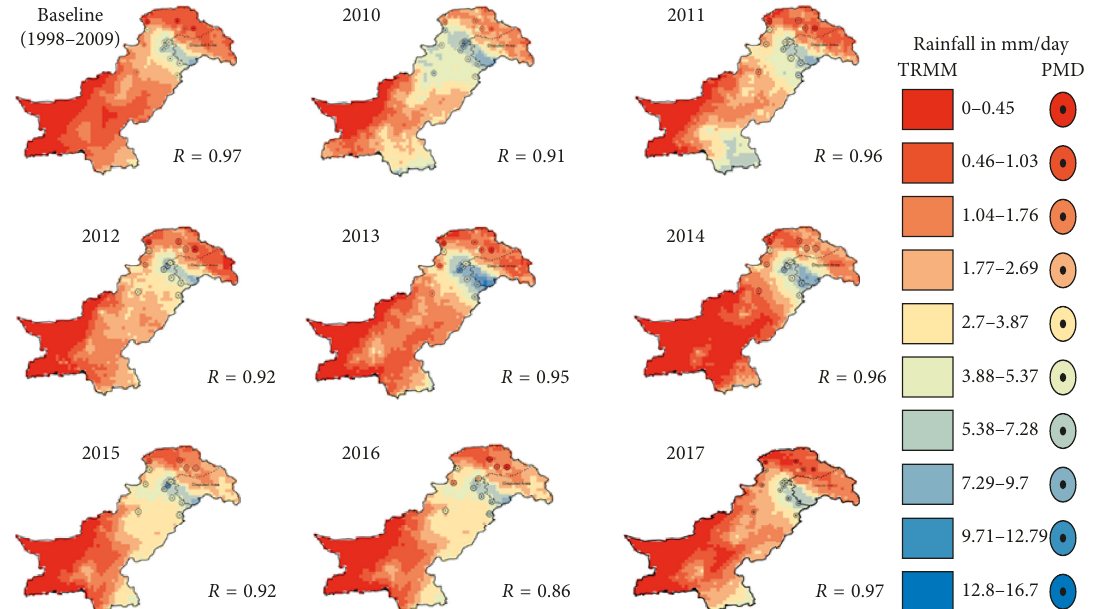
Figure 3: Maps showing rainfall over Pakistan. Correlation between PMD and TRMM_3B43 for seasonal averaged values over selected northern monsoon belt of Pakistan for monsoon season is also listed for respective year. Both the datasets are strongly correlated with Pearson’s correlation “ r ” values ranging from 0.86 to 0.97.